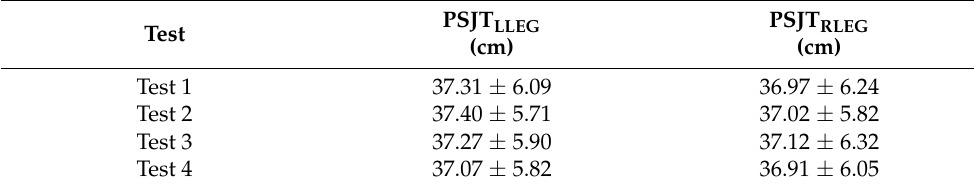
Table 3. Mean ± SD of the PSJT measures obtained during all testing sessions for EGA ( n = 15). Test